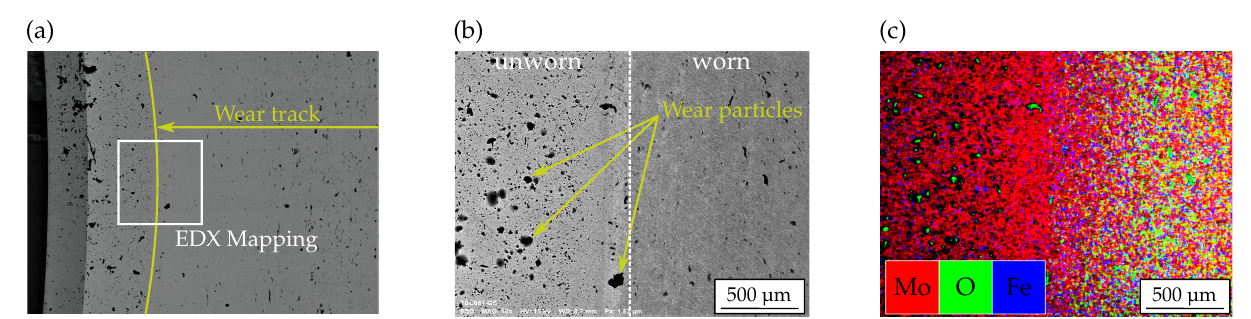
Figure 7. EDX investigations after the experiment on bearing washers: ( a ) Extended view of the bearing washer after experiment with defined area for EDX mapping. ( b ) SE image using InLens detector of the EDX mapping area with unworn and worn area. ( c ) Qualitative elemental mapping of Mo , O , and Fe from the inspected area in ( b